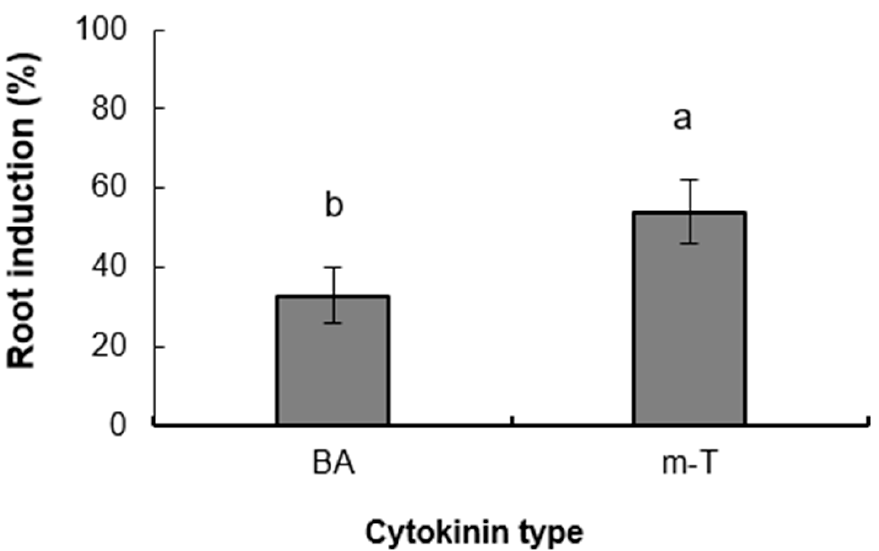
Figure 8. Root induction (%) in shoots of Cryptomeria japonica cultured in QL medium [15], supple- mented with 50 µ M 1-naphthaleneacetic acid (NAA), according to cytokinin type (6-benzyladenine (BA) and meta-topolin (m-T) (8.8 µ M) use during shoot induction stage. Data are presented as mean values ± S.E. Significant differences are indicated by different letters according to Tukey’s post hoc test ( p < 0.05).